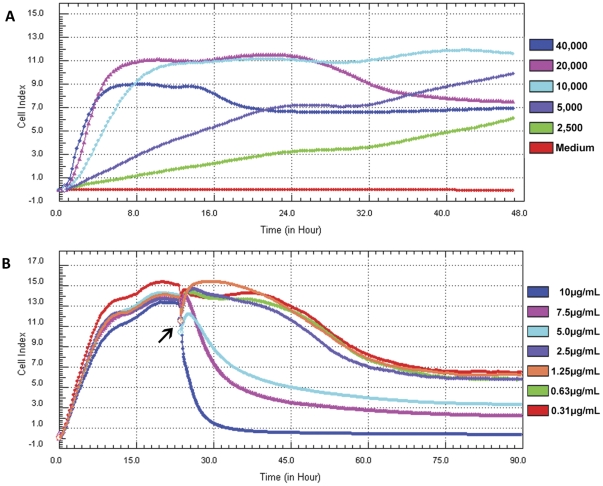
Dynamic monitoring of MDCK cell proliferation.MDCK cells were seeded in the E-Plates and continuously monitored by measuring the CI to identify the appropriate cell numbers, TPCK-trypsin concentration, and the time point for addition of virus (i.e., during growth or early stationary phase). A) Proliferation curves of MDCK cells in cell culture media. B) Proliferation curves of MDCK cells in SFM with TPCK-trypsin. At the indicated time point the cells were inoculated with different concentrations of virus and TPCK-trypsin.